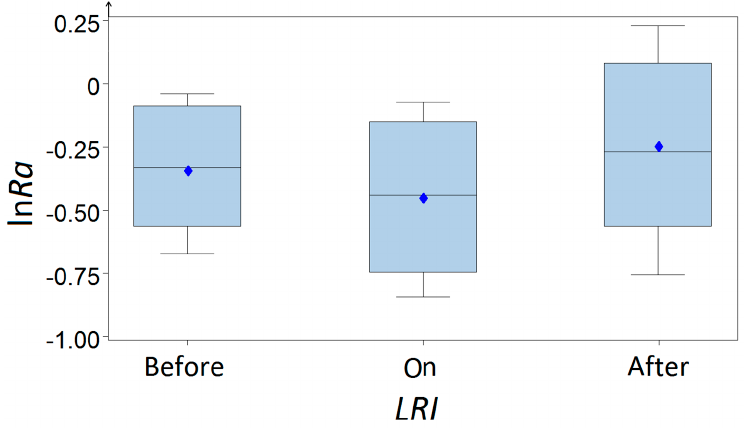
Figure 9. Box and whisker plot with the dispersion of ln Ra versus location with respect to the insert factor.